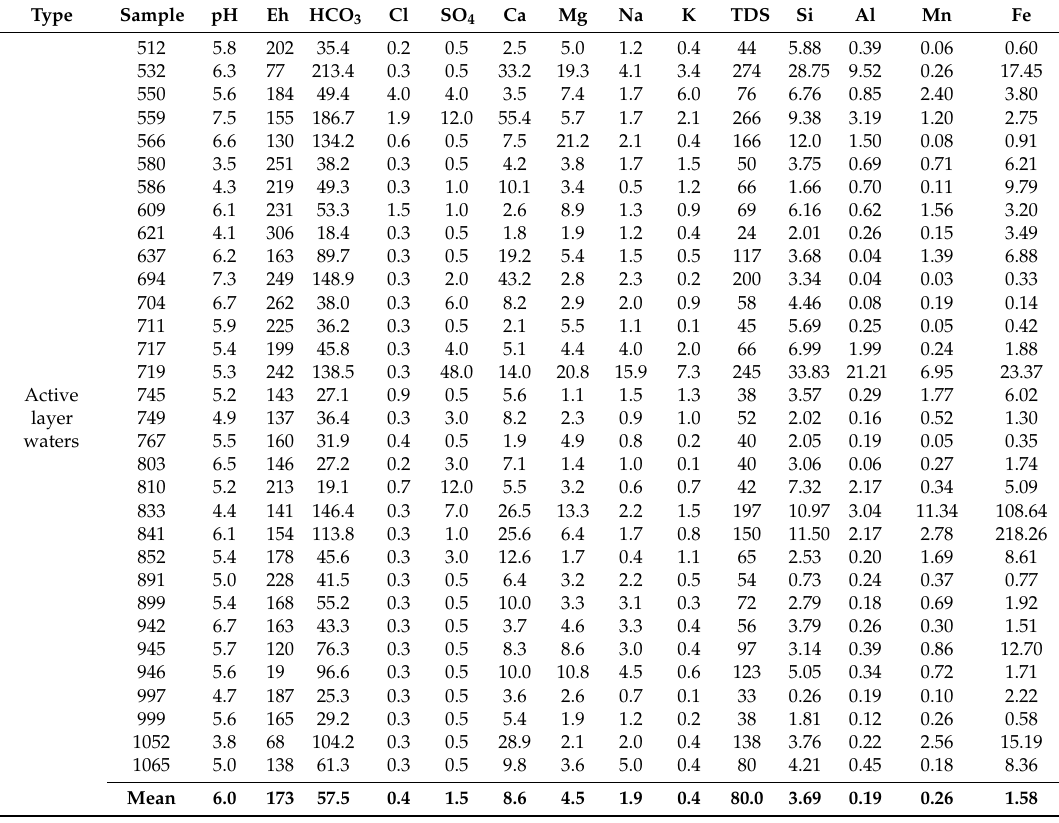
Table A1. Analytical Data on Water Samples: Physico-Chemical Parameters and Major